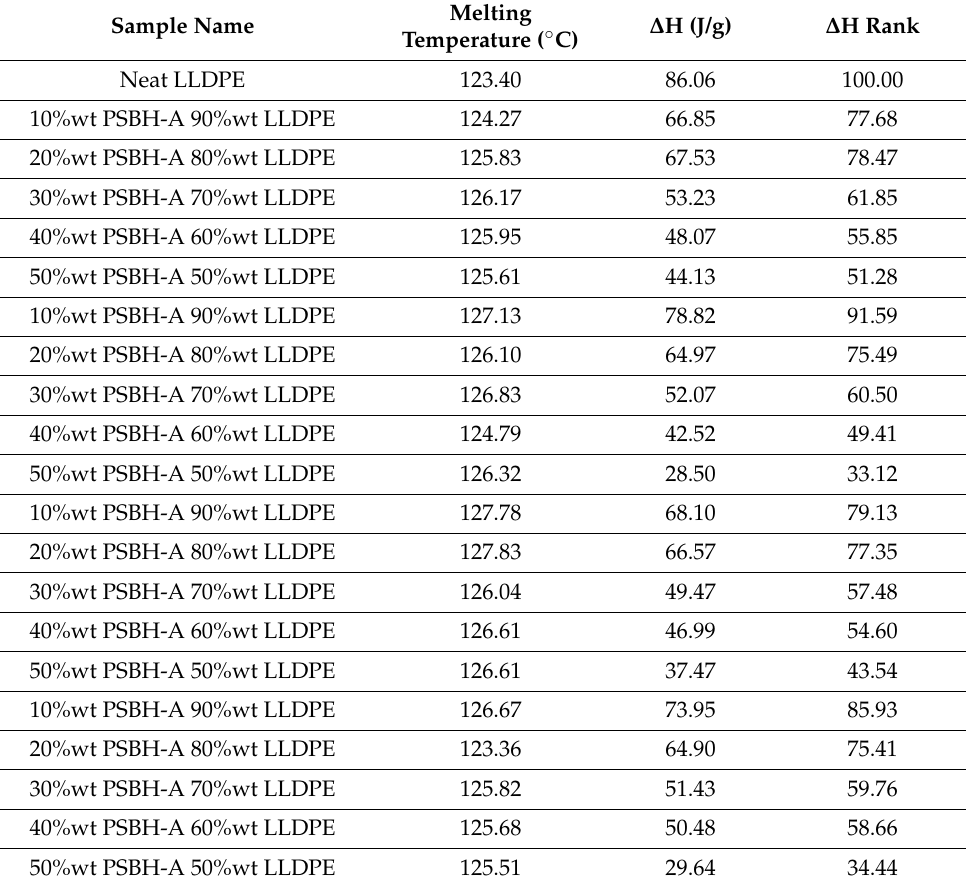
Table 2. Melting temperature and heat of fusion for LLDPE/PSBH